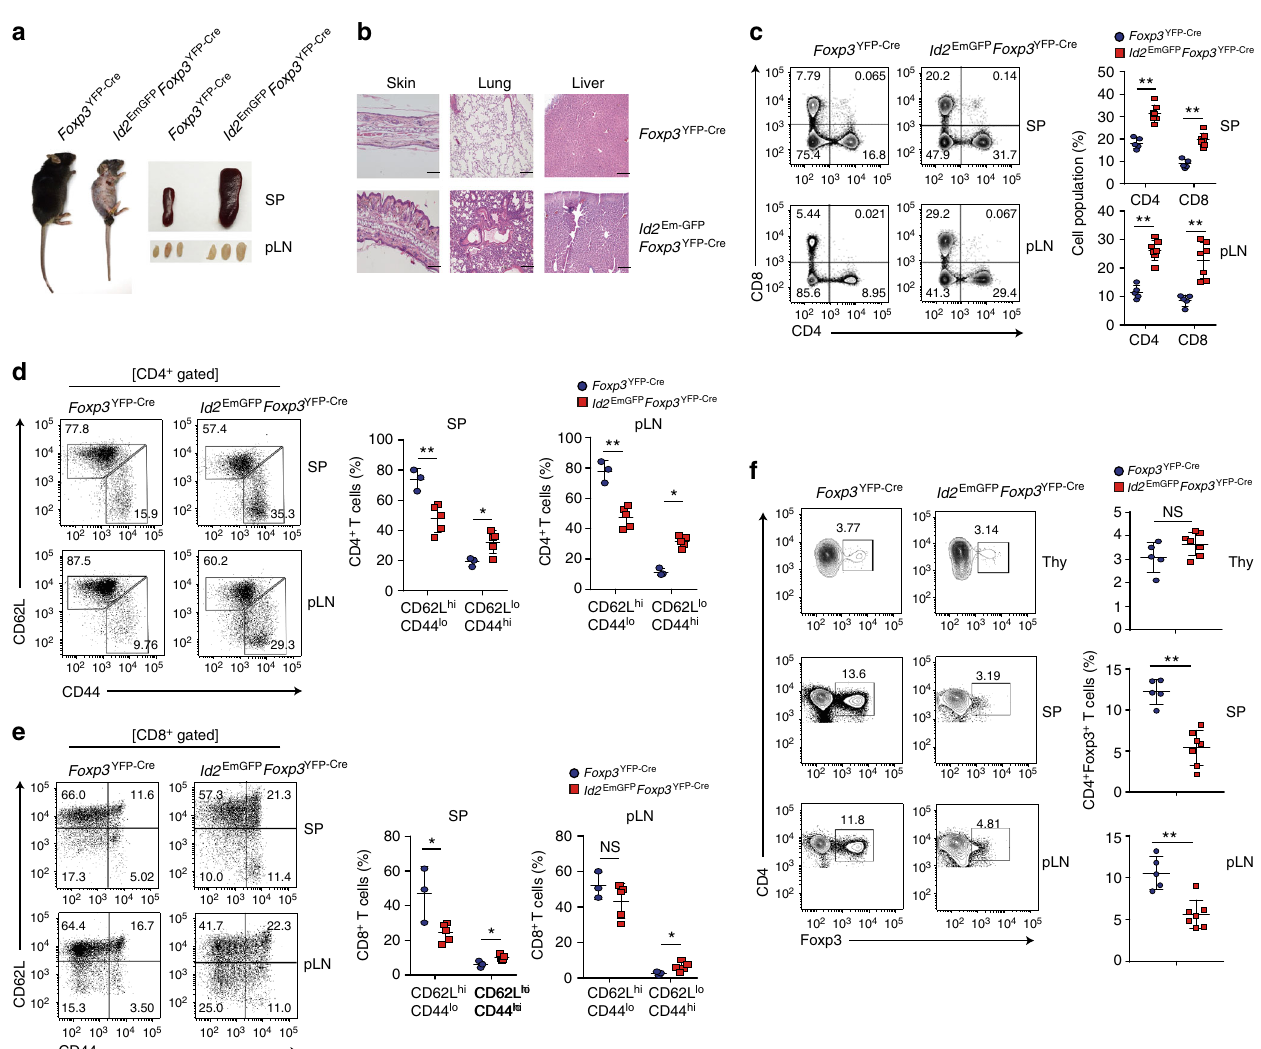
Fig. 4 T reg -cell-speci fi c overexpression of Id2 results in systemic autoimmunity in older mice. a A representative picture of 12 – 16 week-old Foxp3 YFP − Cre and Id2 EmGFP Foxp3 YFP − Cre mice ( left ) and spleen (SP) and peripheral lymph nodes (pLN) derived from them (right). b Representative hematoxylin and eosin (H&E)-stained skin, lung, liver sections from 12 – 16 weeks old Foxp3 YFP − Cre and Id2 EmGFP Foxp3 YFP − Cre mice (scale bar, 100 μ m). c Representative FACS plots and percentages of CD4 + and CD8 + T cells from SP and pLN of 12 – 16 weeks old Foxp3 YFP − Cre and Id2 EmGFP Foxp3 YFP − Cre mice. d , e Representative FACS plots and percentages of CD62L hi CD44 lo (naive) and CD62L lo CD44 hi (effector/memory) cells among CD4 + and CD8 + T cells in SP and pLN 12 – 16 week-old mice. f Representative FACS plots and percentages of Foxp3 + T reg cells in thymus, SP and pLN from 12 – 16 week-old mice. NS, not signi fi cant, *P < 0.05, **P < 0.005 (Student ’ s t -test). All data are representative three independent experiments (error bars,